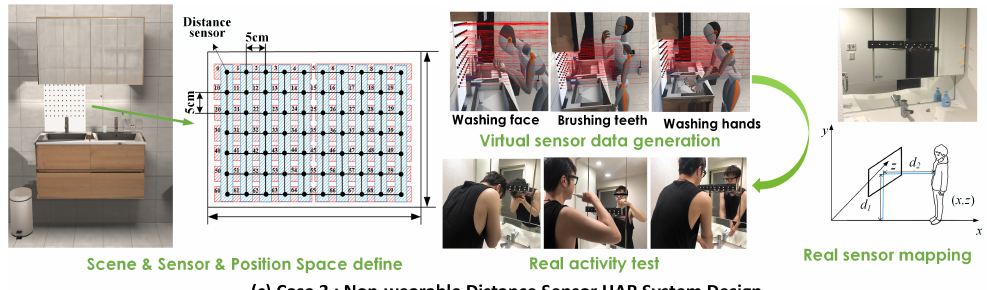
Figure 10. Case 3: Nonwearable distance sensor study. The applied scene is a bathroom. A total of 24 sensor position spaces are found (as the blue/red sensor board position shows) to recognize three types of daily